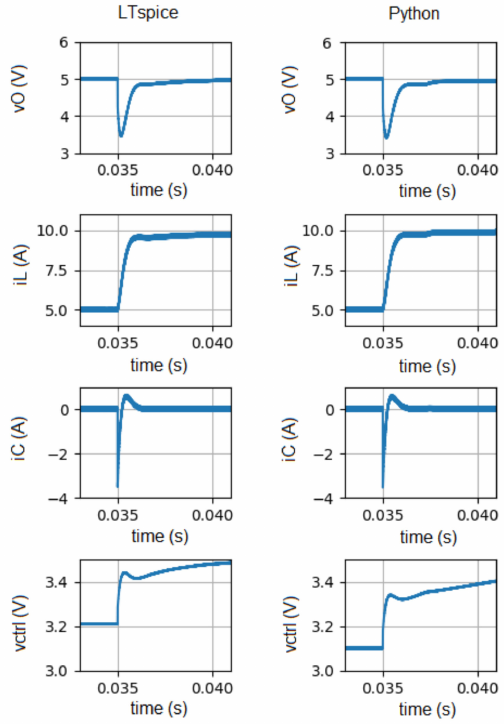
Figure 13. Waveforms of v O , i L , i C and v ctrl obtained during a load variation (from 5 A to 10 A) at 35 ms, with LTspice ( left plots ) and with the proposed simulation technique ( right plots